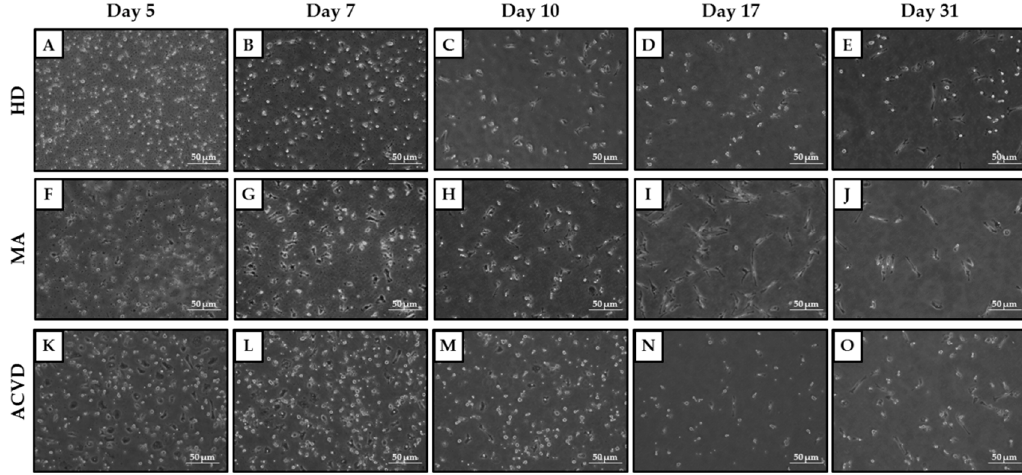
Figure 2. Cultured EPCs from ( A – E ) HD, ( F – J ) MA, and ( K – O ) ACVD representative subjects at 5, 7, 10, 17, and 31 days after seeding in Microvascular Endothelial Cell Growth Medium (EGM-MV medium) (20 × magnification, 50 µ m scale